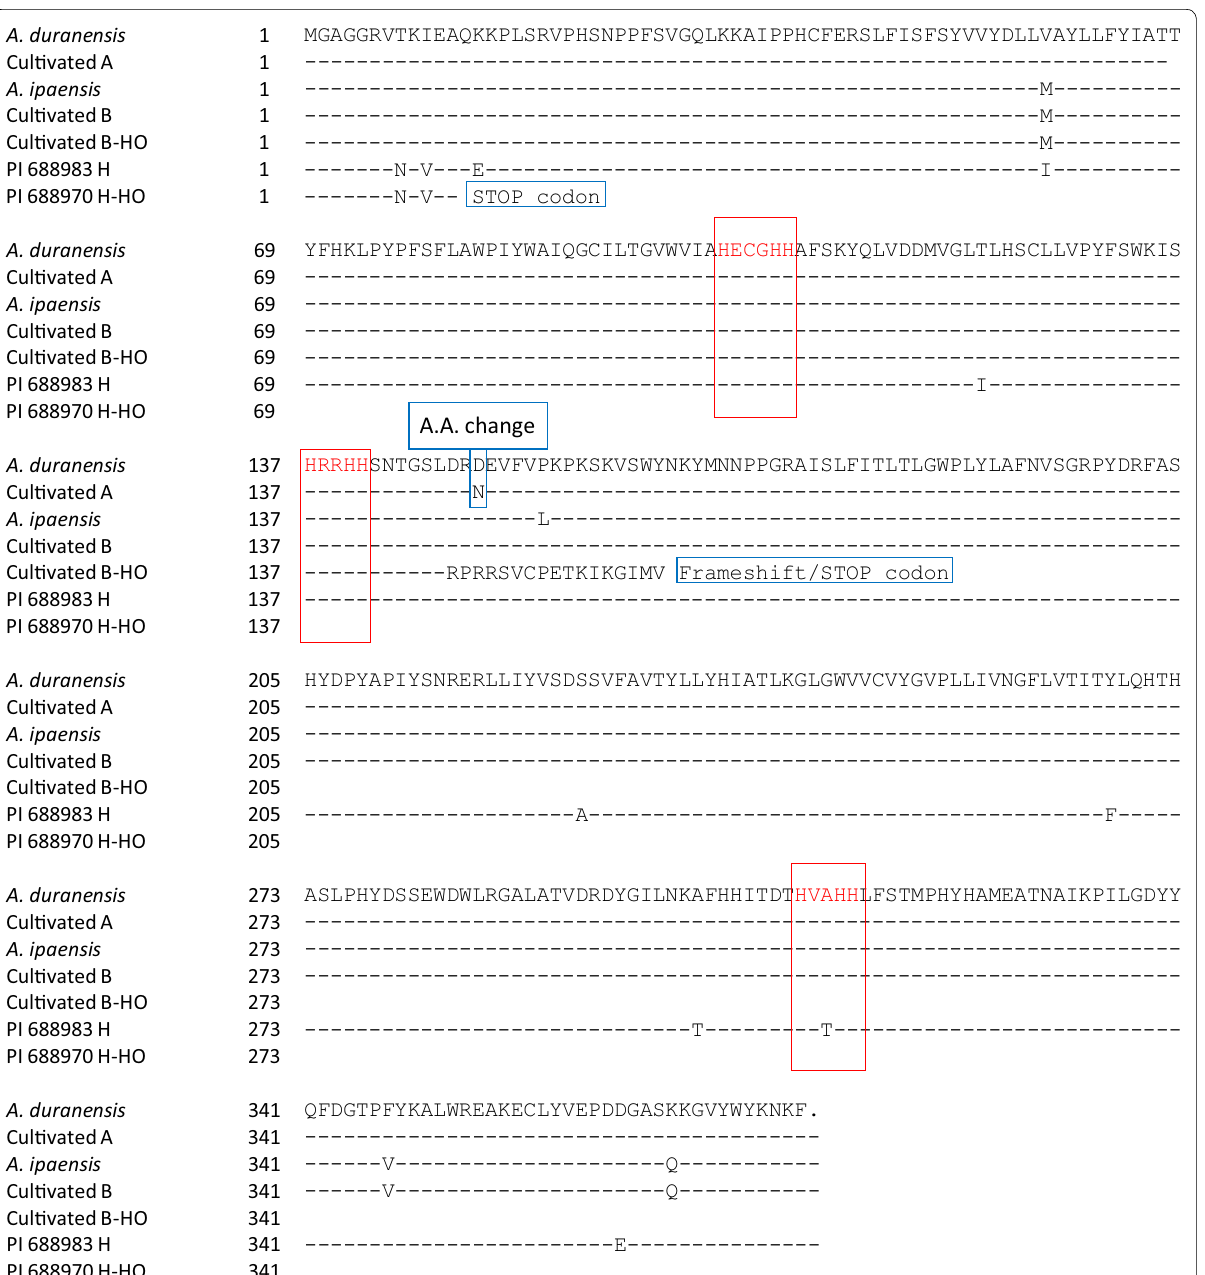
Fig. 3 Comparison of deduced amino acid sequences of fatty acid desaturase (FAD) and identification of amino acid changes. Cultivated A and Cultivated B represent subgenomes A and B from cultivated peanut Tifrunner. Cultivated B-HO represent subgenome B from F435 with high oleic acid trait. Two blue rectangles represent stop codon and frameshift/stop codon. Three red rectangles represent three histidine (His)